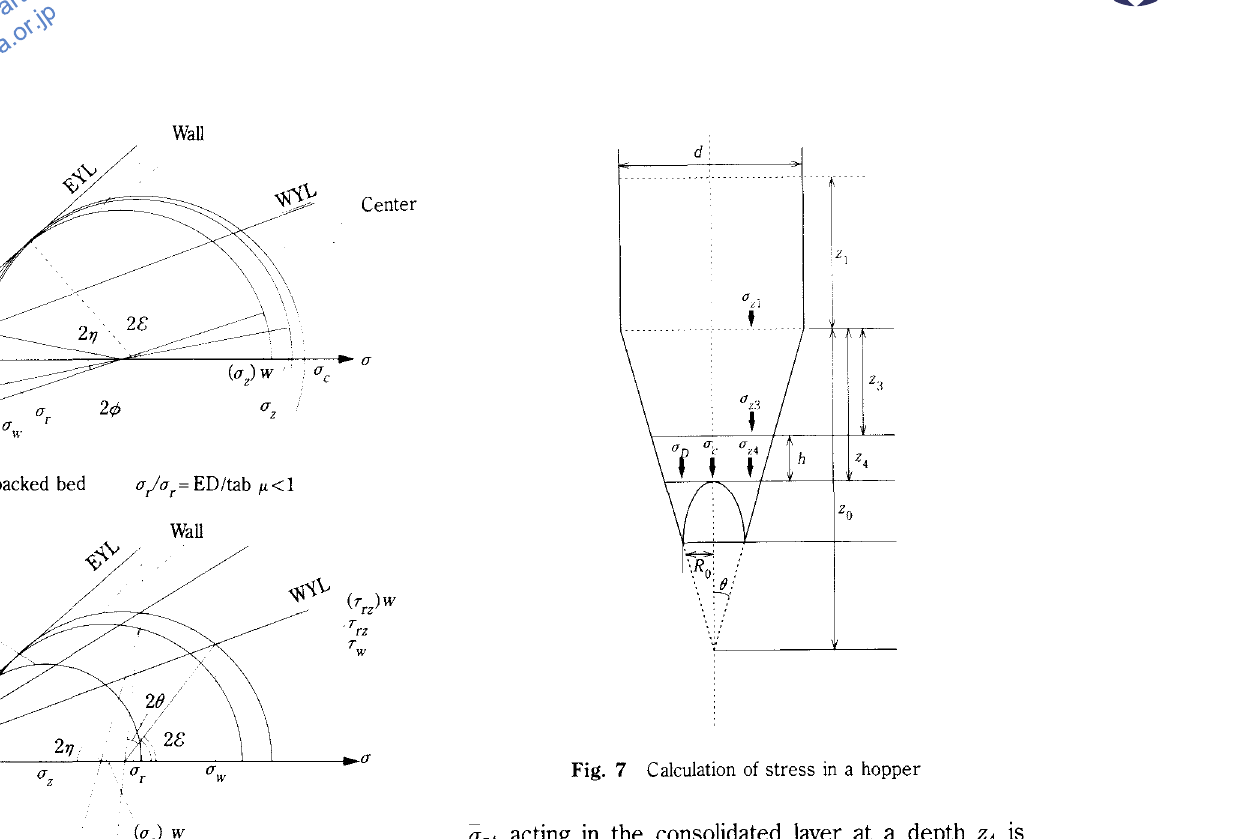
Fig. 6 Stress condition in a hopper